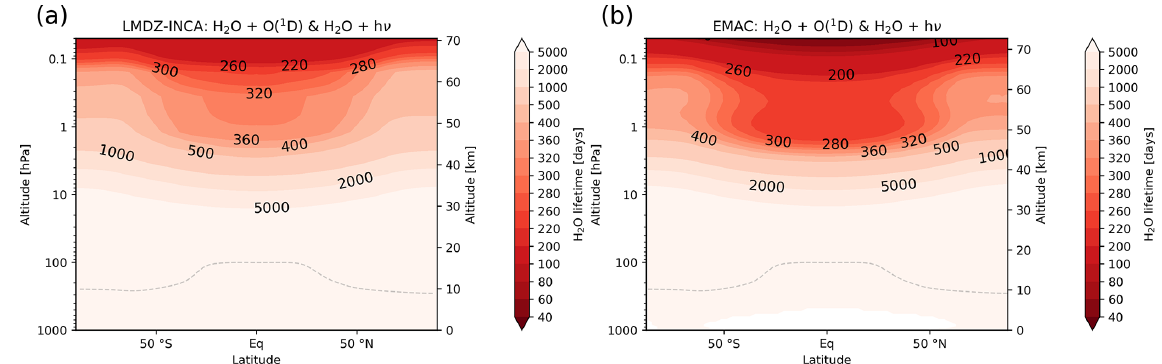
Figure 6. Zonal mean (photo-)chemical H 2 O lifetime in days dependent on photolysis and reaction with O( 1 D) for LMDZ-INCA (a) and EMAC (b) . Figure A5, showing both reactions independently, can be found in the Appendix.